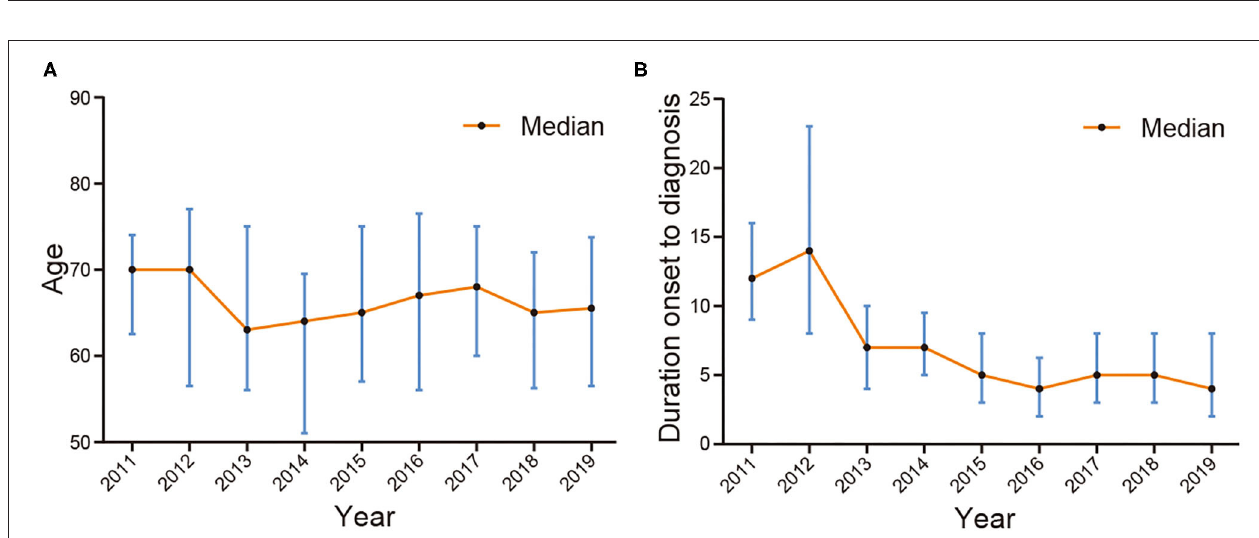
FIGURE 3 | The median age and interval from illness onset to confirmation of SFTS cases in Zhejiang Province from 2011 to 2019. (A) is the median age and (B) is the interval from illness onset to confirmation.